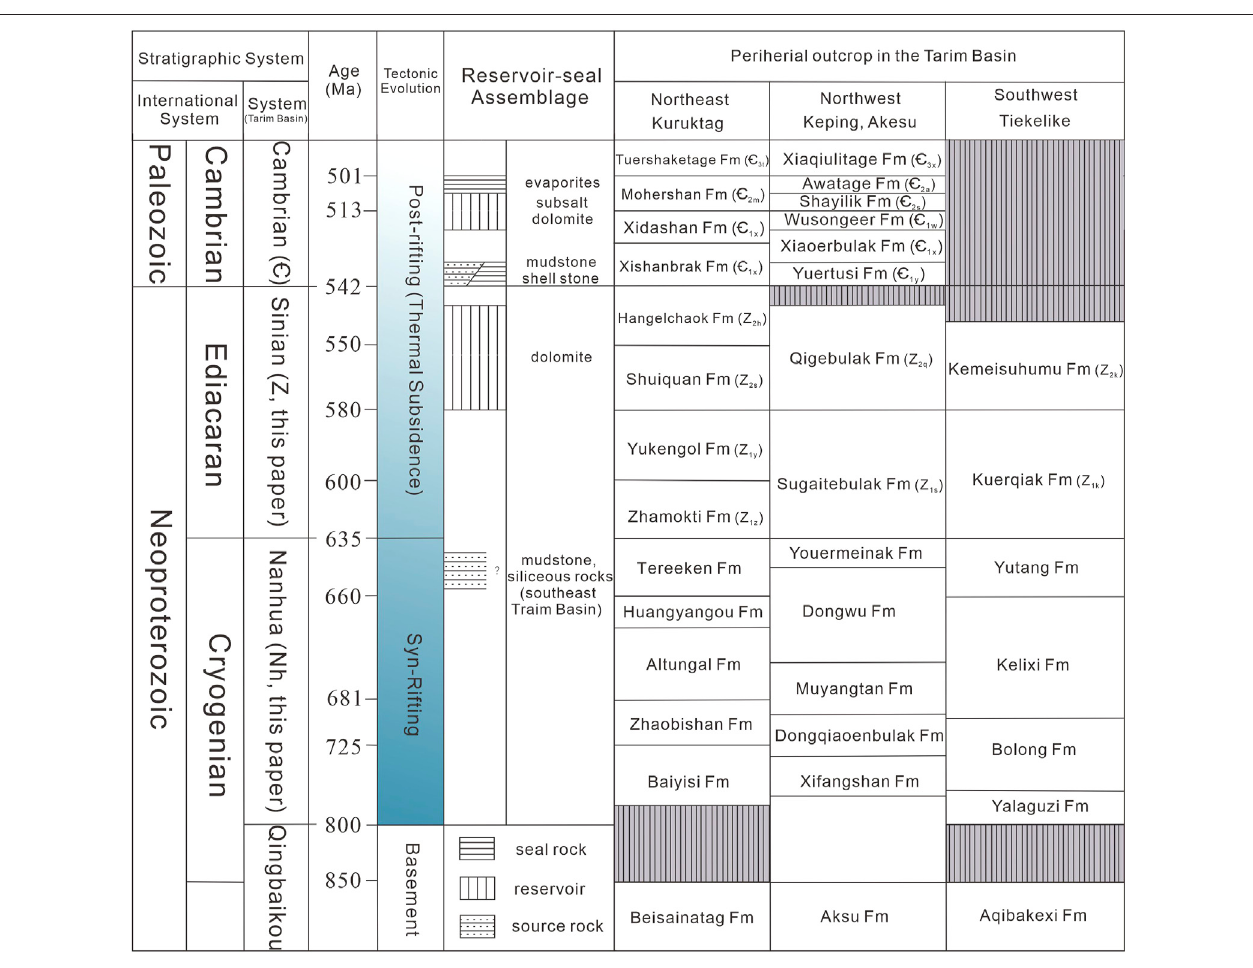
FIGURE 2 | Nanhua – Cambrian sequences and reservoir – seal assemblages in the Tarim Basin and its adjacent areas (modi fi ed from Xinjiang BGMR, 1993).